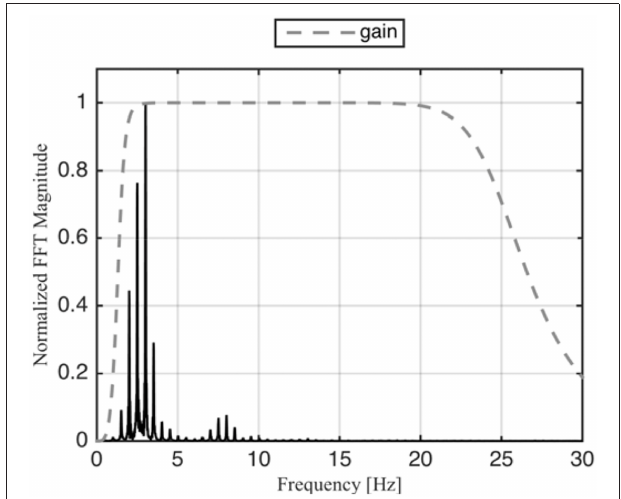
FIGURE 5 | Normalized Fourier spectrum (obtained via Fast Fourier Transform) and band-pass filter (dashed line).